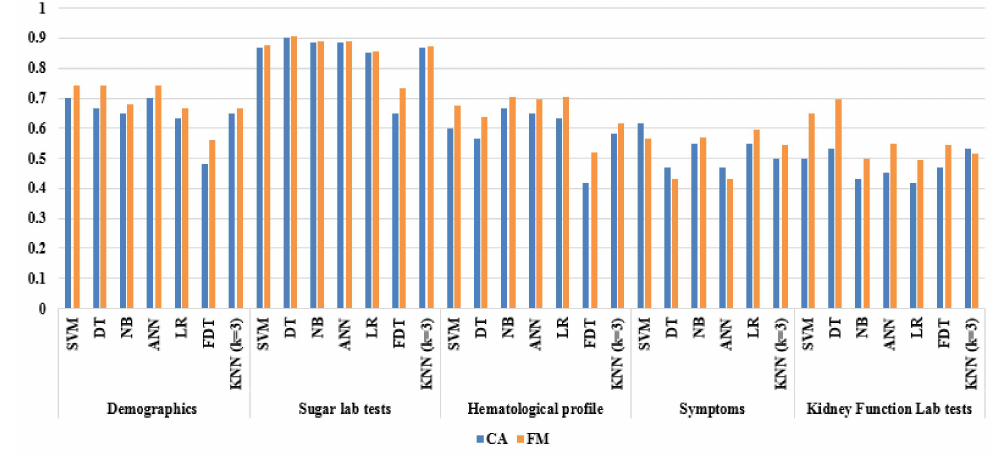
Figure 6. A comparison between CA and FM for base classifiers using wrapper FS (part 1).